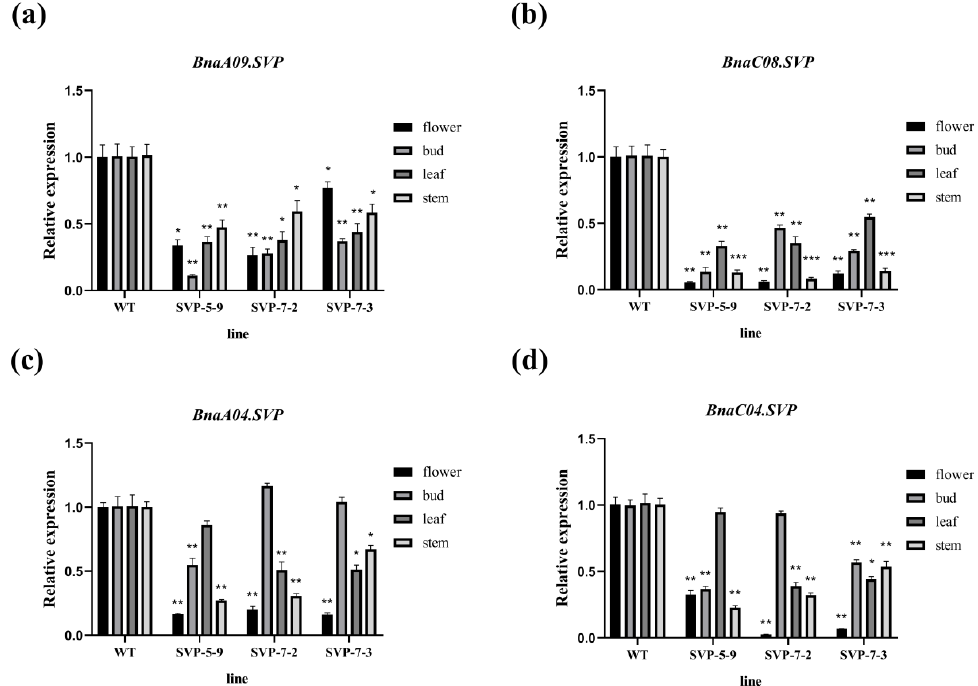
Figure 7. Fluorescence quantitative analysis after BnaSVP copy mutation. ( a – d ) The expression levels of BnaA09.SVP , BnaC08.SVP , BnaA04.SVP , and BnaC04.SVP were altered in the mutants. WT represents wild type; * p < 0.05, ** p < 0.01, *** p < 0.001.